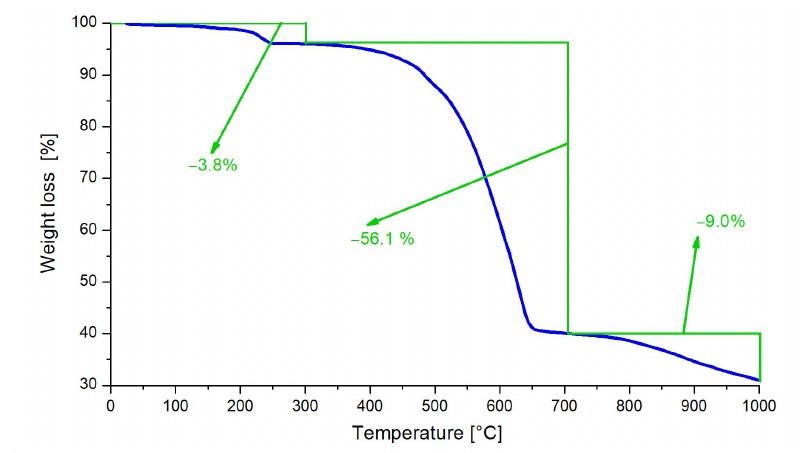
Figure 5. TG measurement of Cs 2 [Mn(NH 2 ) 4 ] at 5 K/min in argon flow. Proposed decomposition steps have been added to the figure together with measured percentage mass